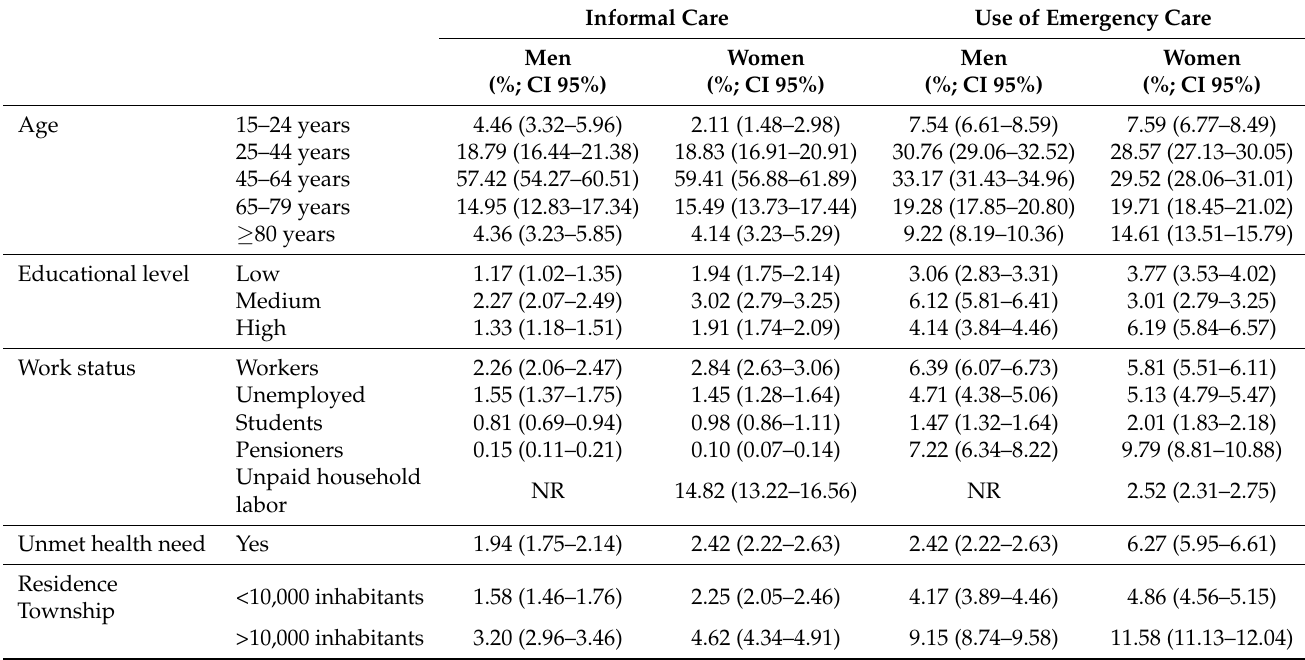
Table 4. Prevalence of informal care and the use of emergency service care in men and women by age, educational level, unmet health needs and residence township, Spain 2017. Weighted and standardized results by 2017